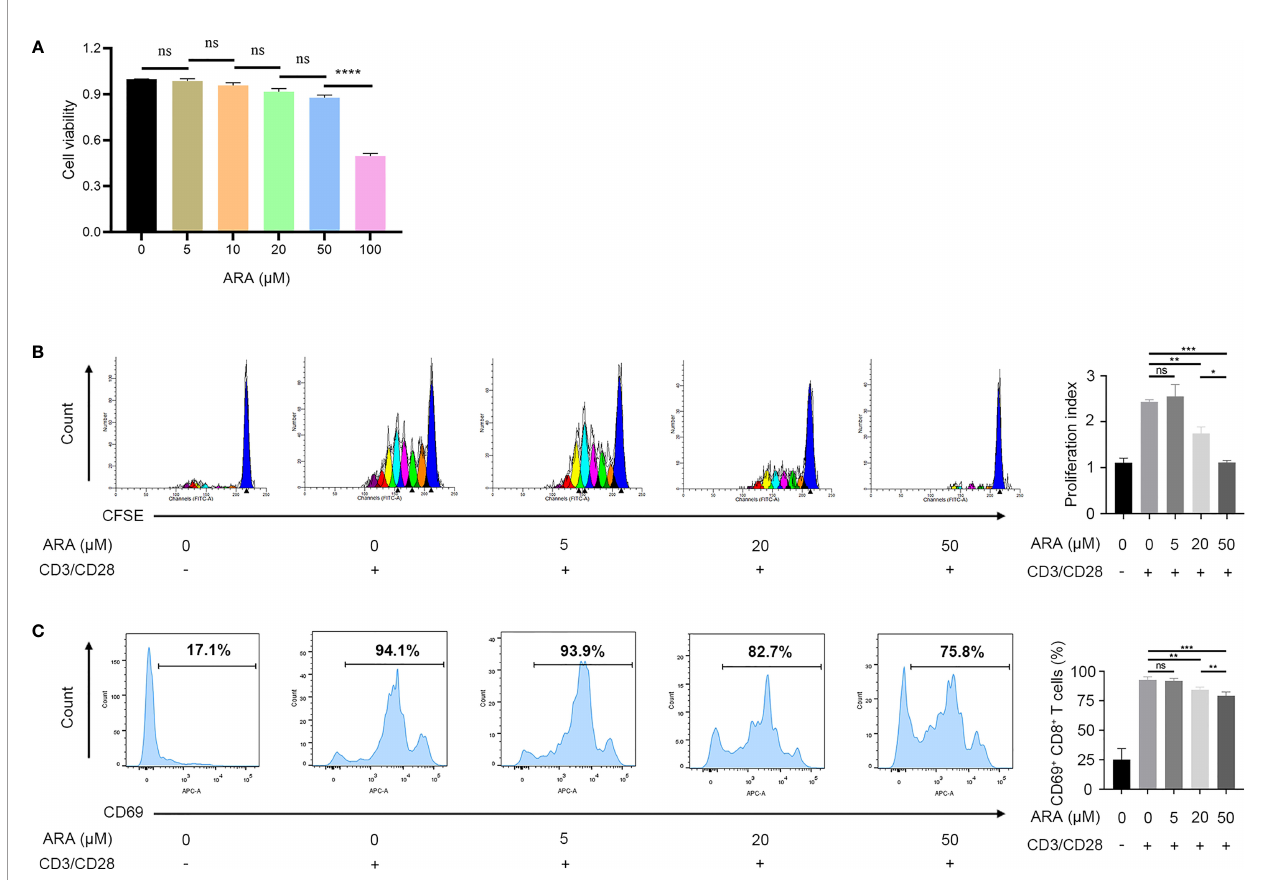
FIGURE 5 | ARA inhibited the proliferation and activation of CD8 + T cells in a concentration-dependent manner. (A) The cell viability of CD8 + T cells on ARA by CCK-8 assay (n = 3). (B) Flow cytometric analysis of CD8 + CFSE + labeled T cells in vitiligo PBMCs after stimulation with anti CD3/CD28 for 5 days with ARA 0 to 50 m M (n = 3). (C) Flow cytometric analysis of CD8 + CD69 + labeled T cells in vitiligo PBMCs after stimulation with anti CD3/CD28 for 1 days with ARA 0 to 50 m M (n = 6). ARA, arachidonic acid; m M, m mol/l; ns, no signi fi cance, * P < 0.05, ** P < 0.01, *** P < 0.001, **** P <